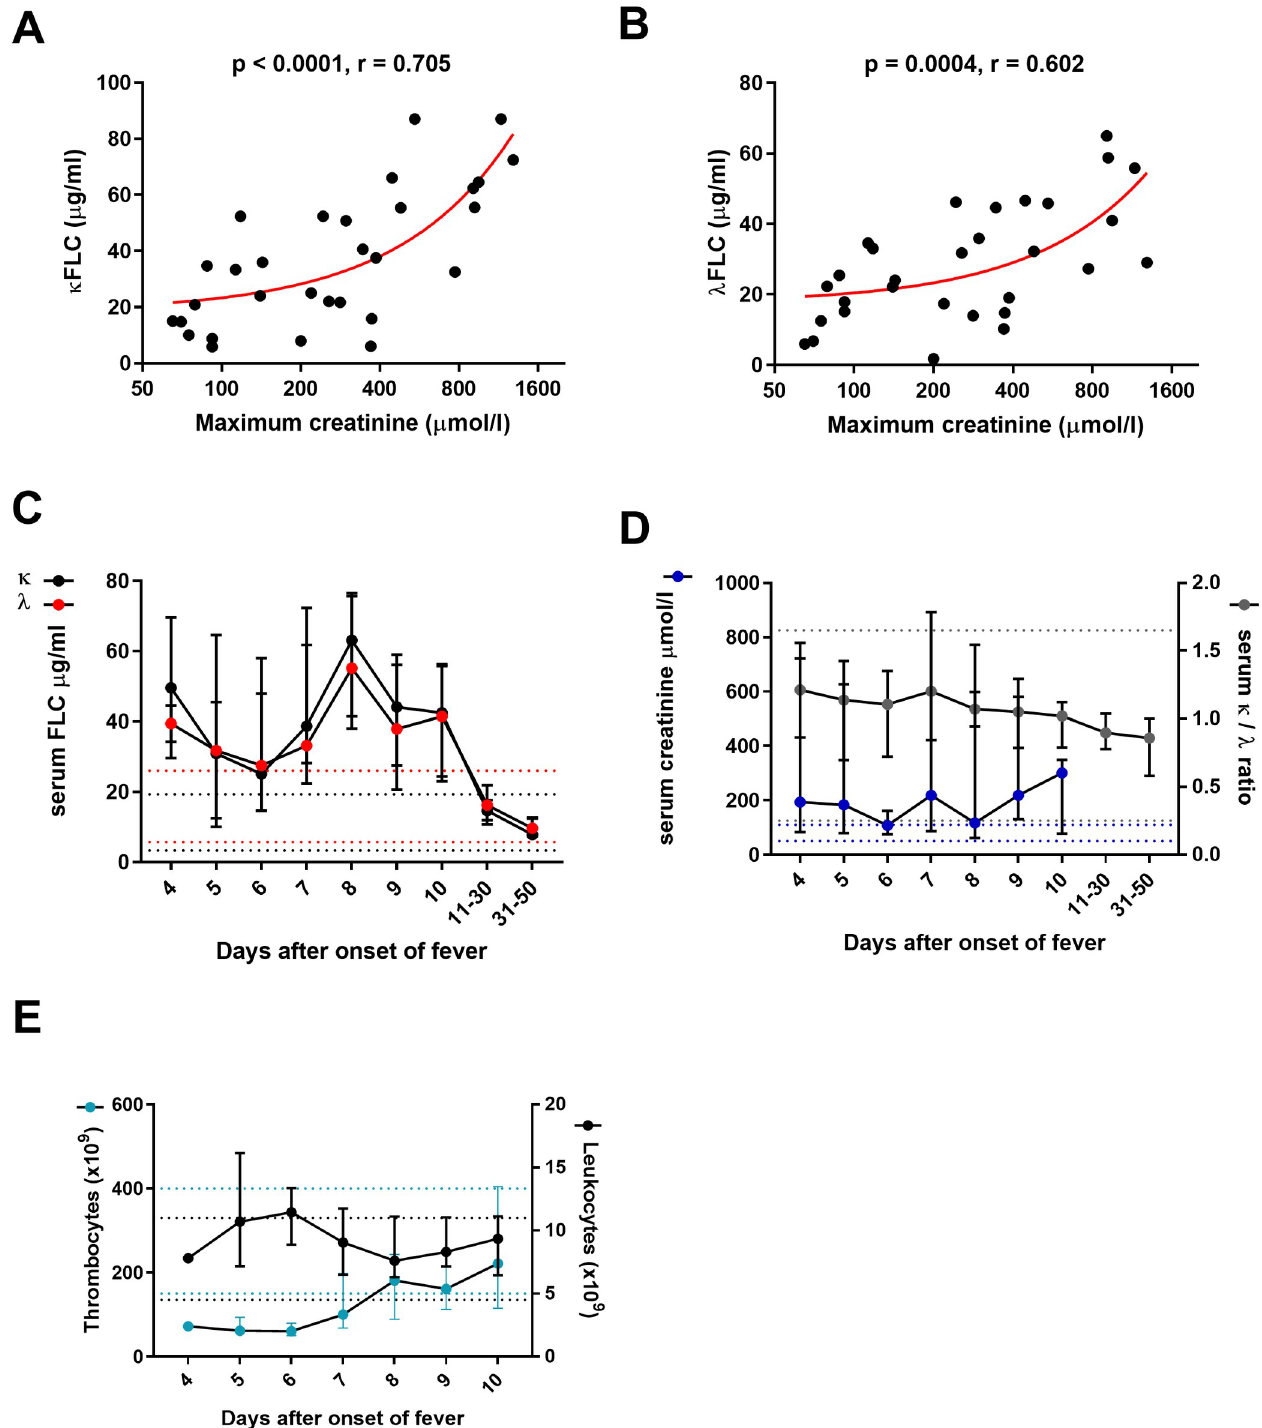
Fig 2. Soluble FLCs correlate with the extent of kidney injury in HFRS. ( A and B ) To assess the prognostic value of serum FLC levels for acute kidney injury, the concentration of FLCs ( κ in A and λ in B ) in serum samples collected at first day of hospitalization from patients with acute PUUV-HFRS (n = 30) were correlated to the maximum serum creatinine values measured during the hospital stay, using Spearman’s rank correlation coefficient. Non-linear association between parameters is depicted by the red line. ( C ) The serum concentration of FLCs were measured in sequential serum samples obtained from patients hospitalized due to PUUV-HFRS (total patient n = 13, n for individual time points depicted in S1 Fig) in acute stage (days 4–10 after onset of fever) and convalescence (grouped as 11–30 and 31–50 days after onset of fever). From the same samples as in ( C ), two indicators of renal clearance function, serum